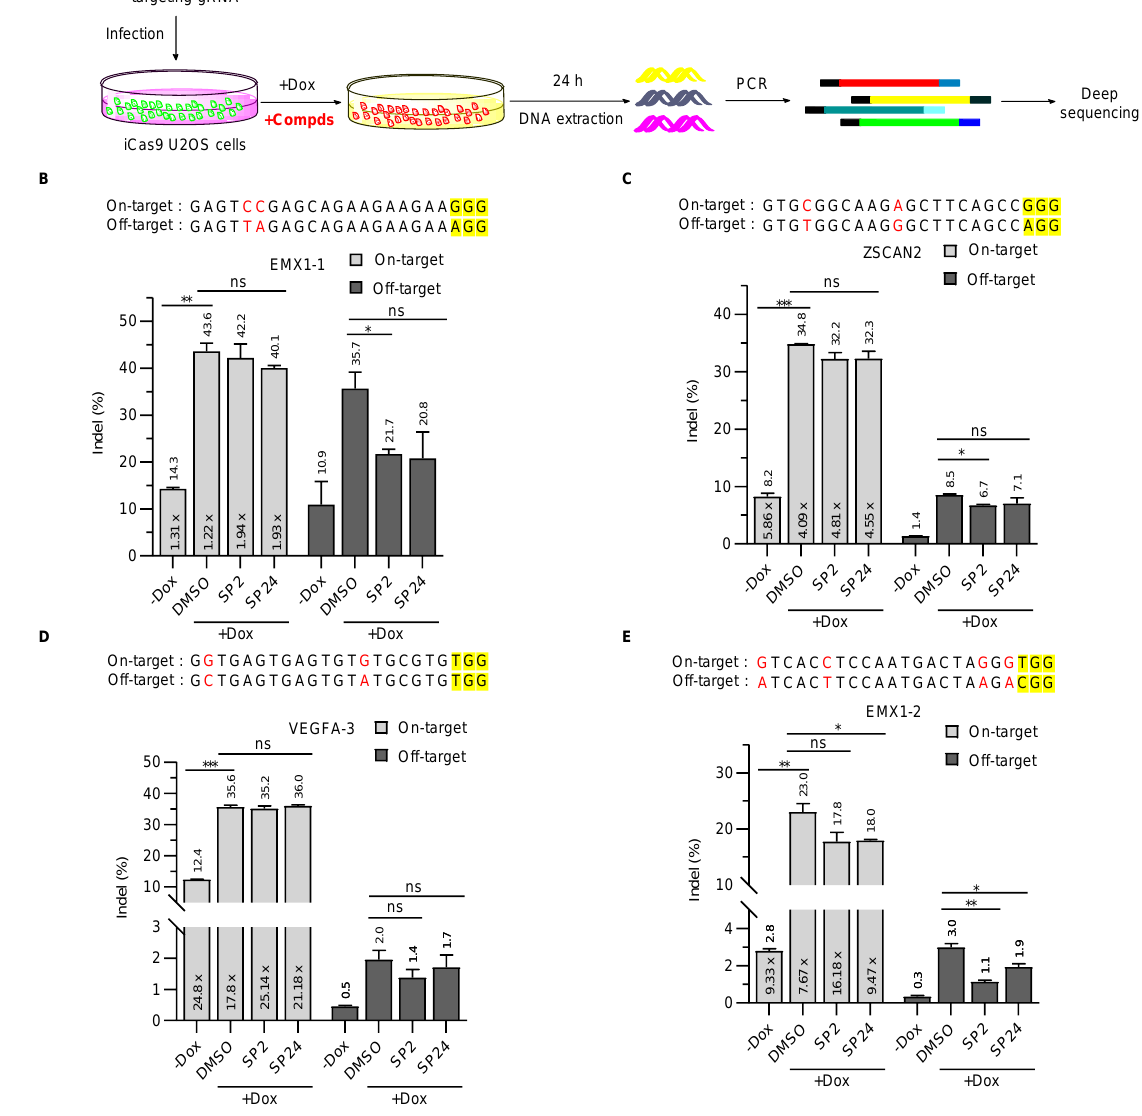
we carried out competitive fluorescence polarization (FP) assays, where interaction